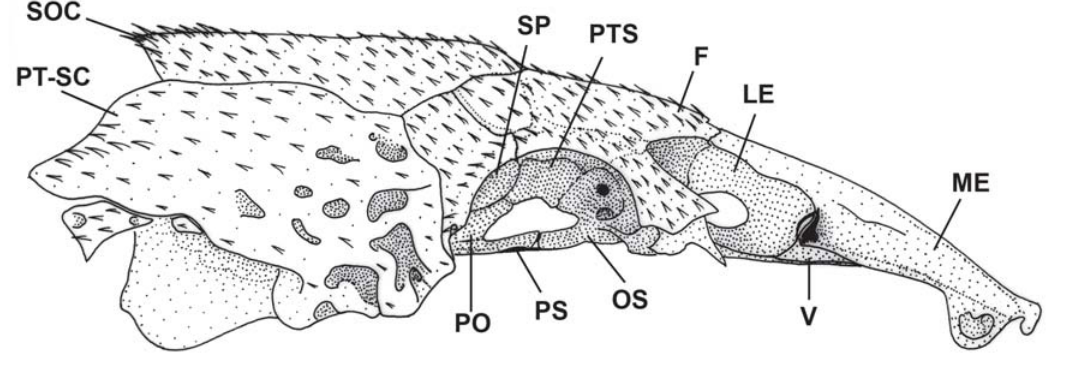
Fig. 6. Skull of Otothyropsis marapoama, paratype LIRP 5641, 29.0 mm SL, in lateral view. Dermal plates of the dorsal snout anterior to the frontals removed. Anterior to